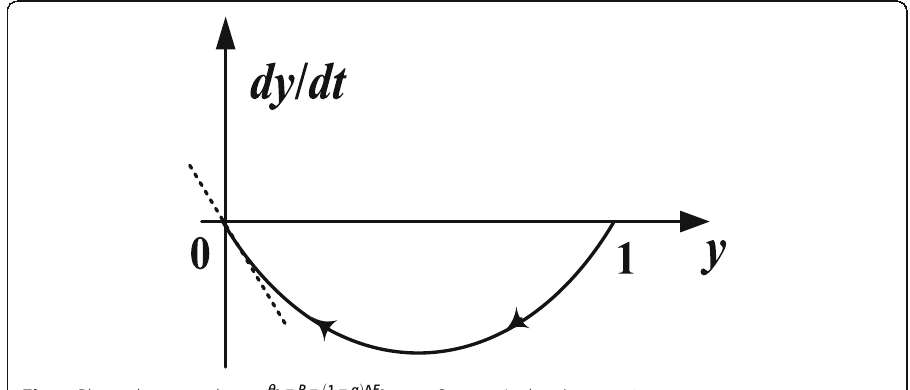
> 1 ; Source: Authors ’ Fig. 5 Phase diagram when θ 2 − P − ð 1 − α Þ Δ E 2 ð 1 − α Þ ∙ ð Δ π − Δ E 1 − Δ E 2 Þ